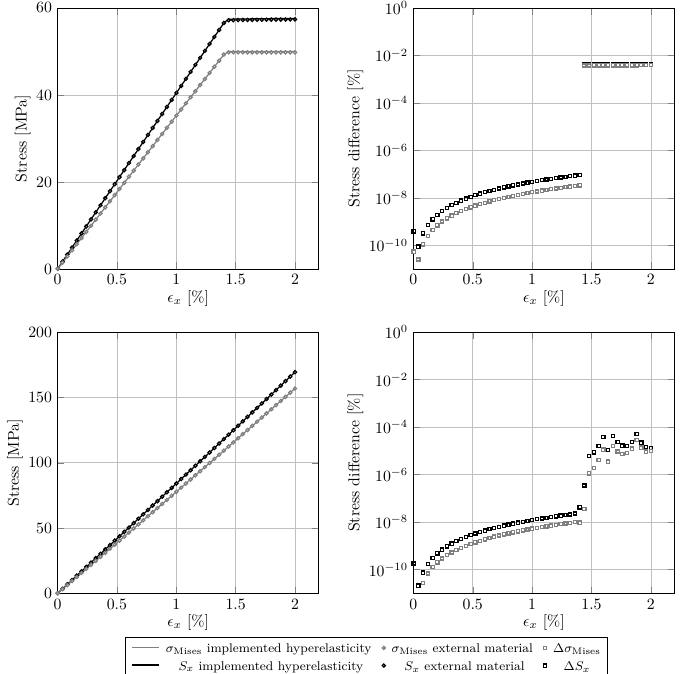
Figure 9. Numerical validation of the implemented general stress–deformation algorithm in COMSOL Multiphysics ®